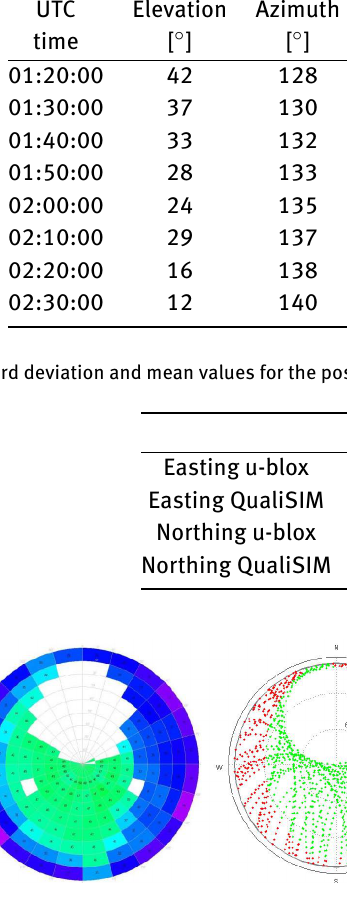
Figure 8: Skyplot illustration, Signal to Noise Ratio [dB] to the left and categorisation of visibility to the right.